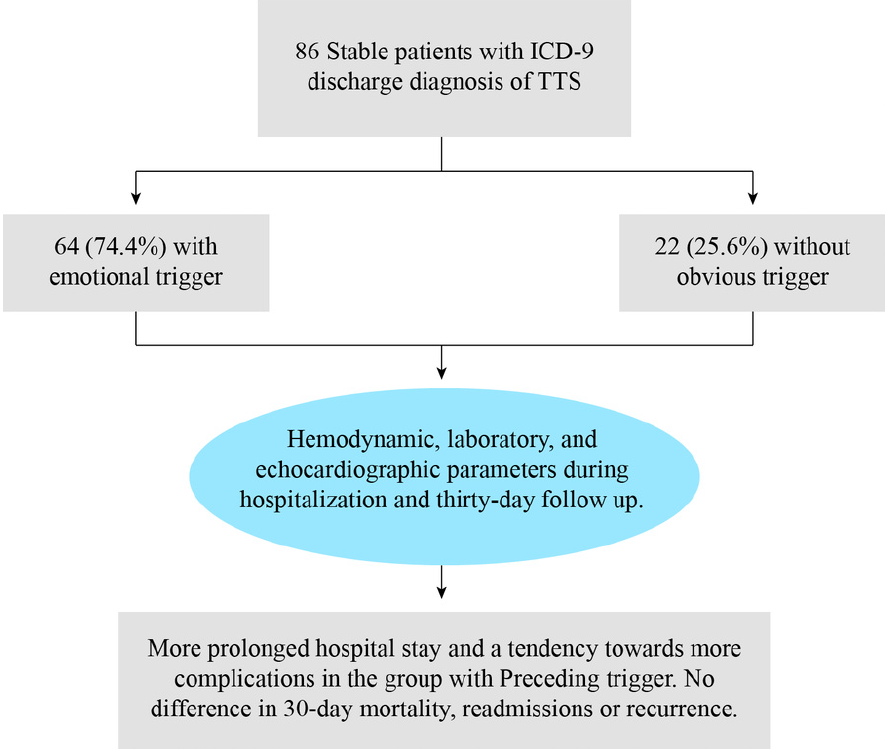
Figure 2. Flow diagram of the study.